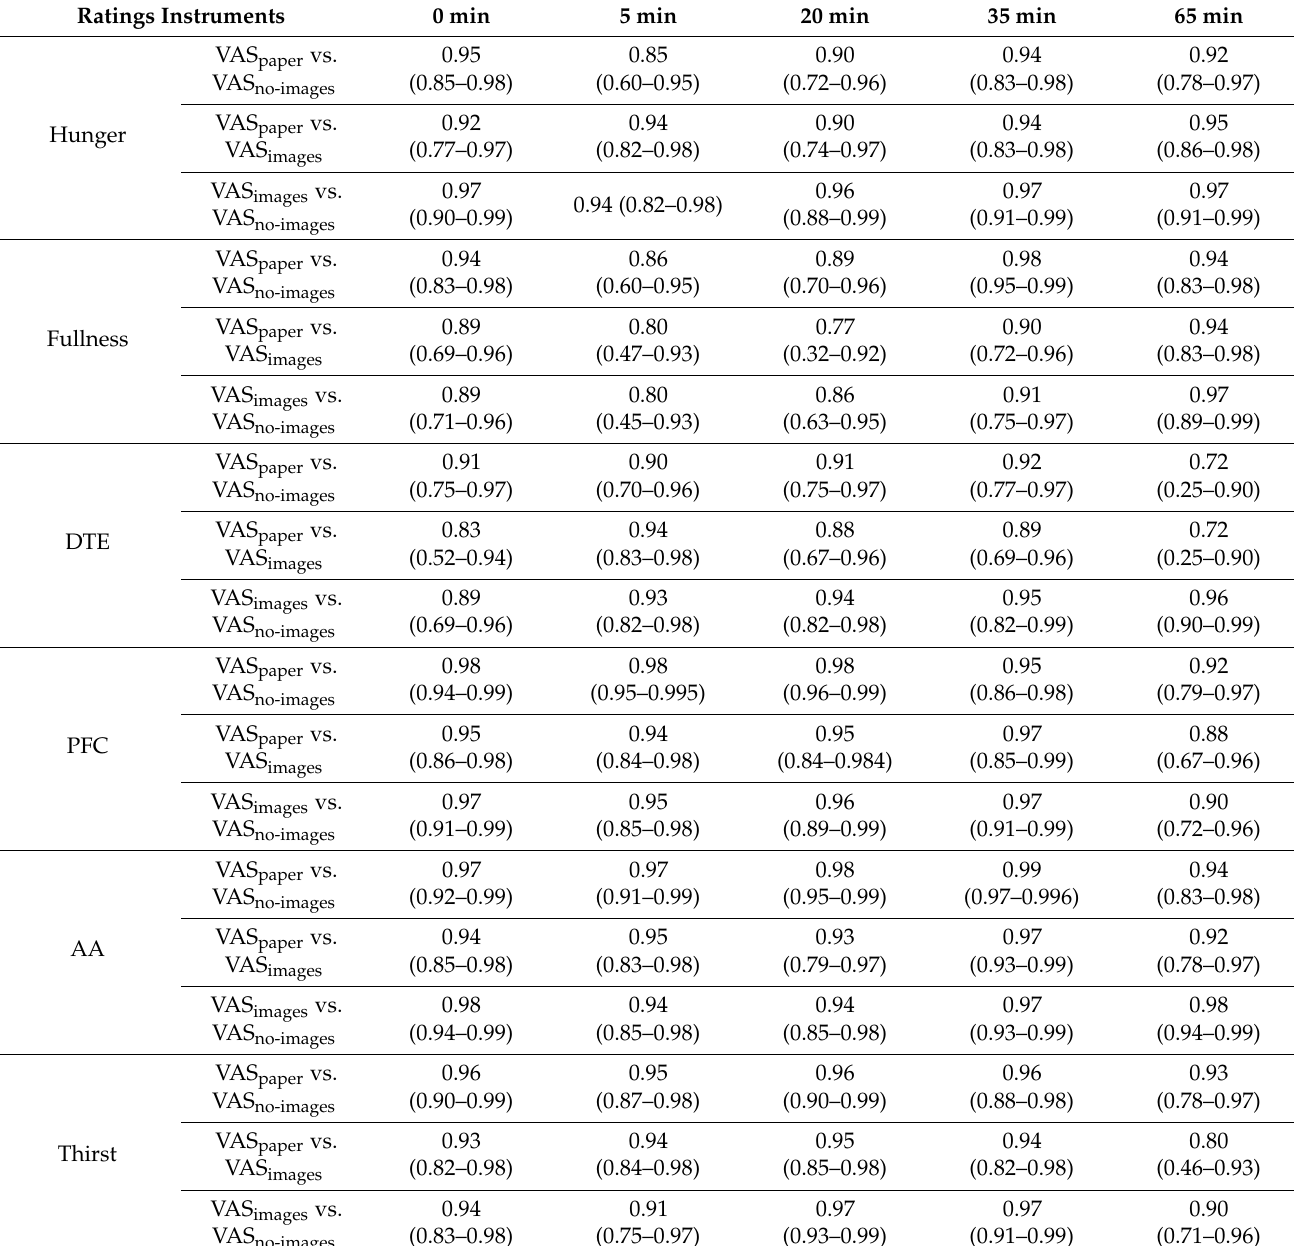
Table 2. ICCs evaluating agreement between the three VAS